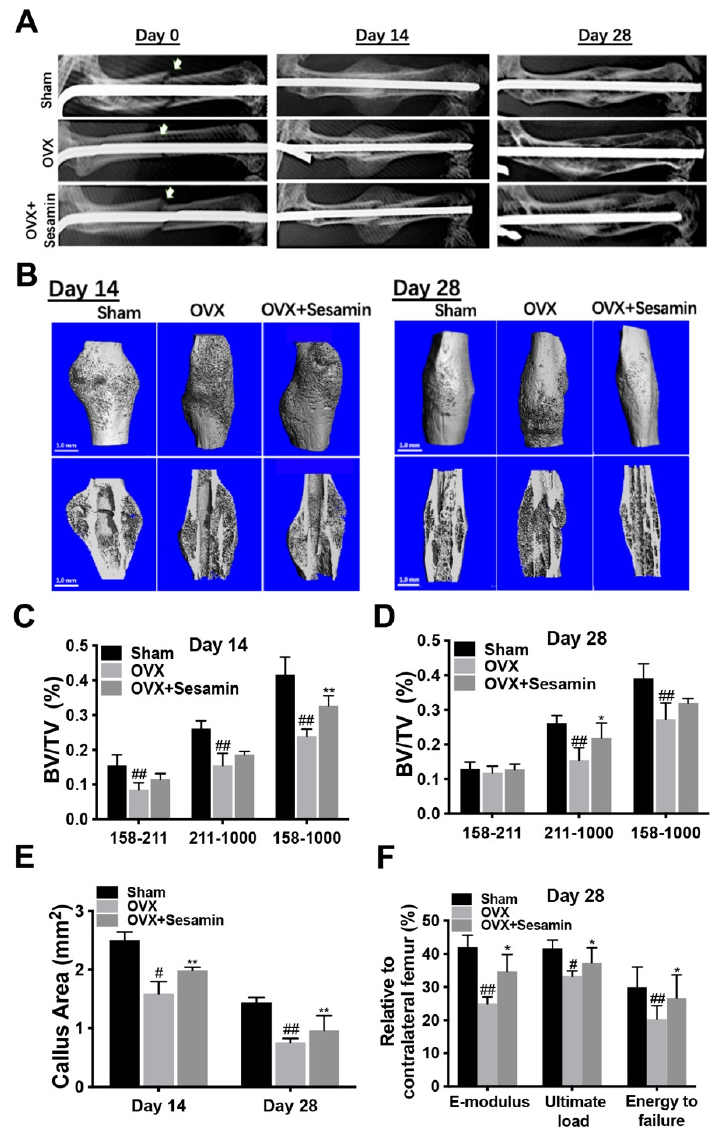
Figure 4. Sesamin promoted osteoporosis fracture healing in vivo: ( A ) X-ray images of the fracture femurs at different time points (the fracture sites were indicated by white arrows). ( B ) Three-dimensional reconstruction images of new formed callus 14 or 28 days after surgery. ( C , D ) Bone volume/tissue volume (BV/TV) in each group at day 14 ( C ) and 28 ( D ) post-surgery. ( E ) Measurements of callus area at different timepoints after surgery. ( F ) Analysis of biomechanical parameters including E-modulus, ultimate load and energy to failure of fractured femurs normalized to non-fractured femurs at day 28 post-surgery ( n = 6; # p < 0.05, ## p < 0.01 vs. Sham group; * p < 0.05, ** p < 0.01 vs. OVX group).